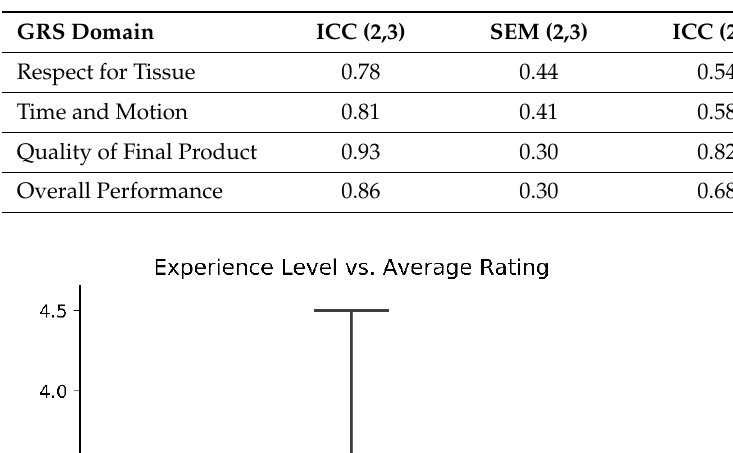
Table 5. Human raters show good to excellent agreement on the held-out test set. Determining agreement on the same test set the AI model is evaluated on can help provide a better baseline for expected performance.